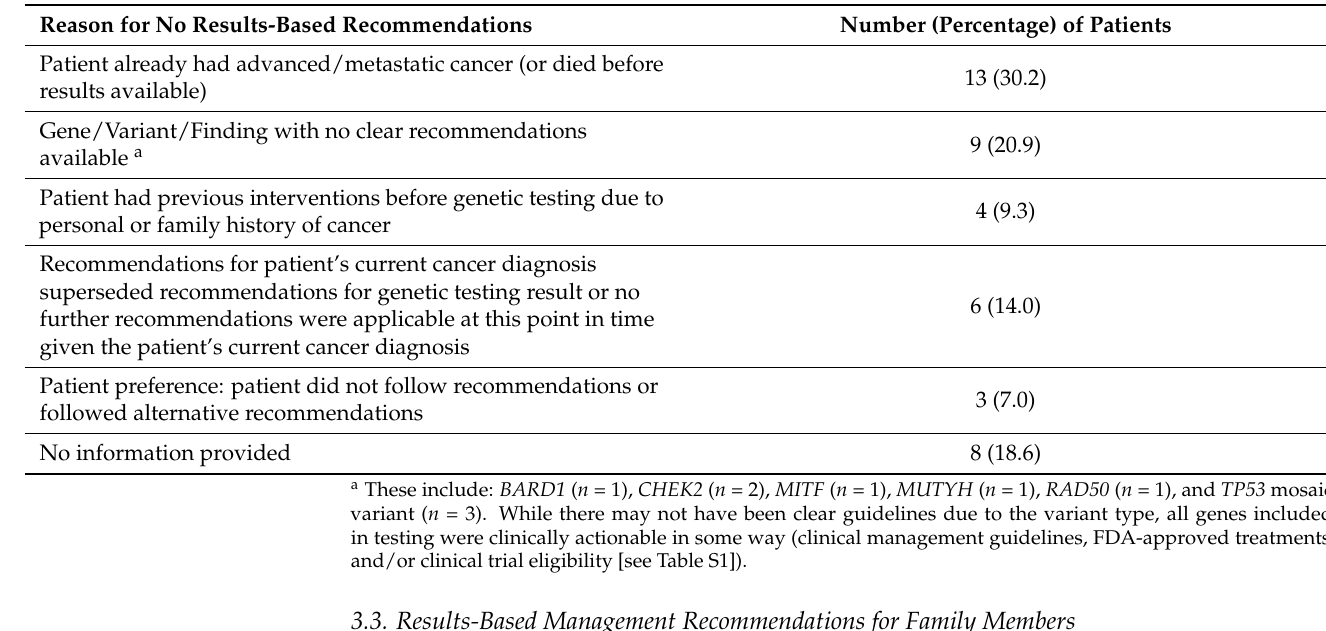
Table 2. Reasons for not making results-based recommendations ( n =